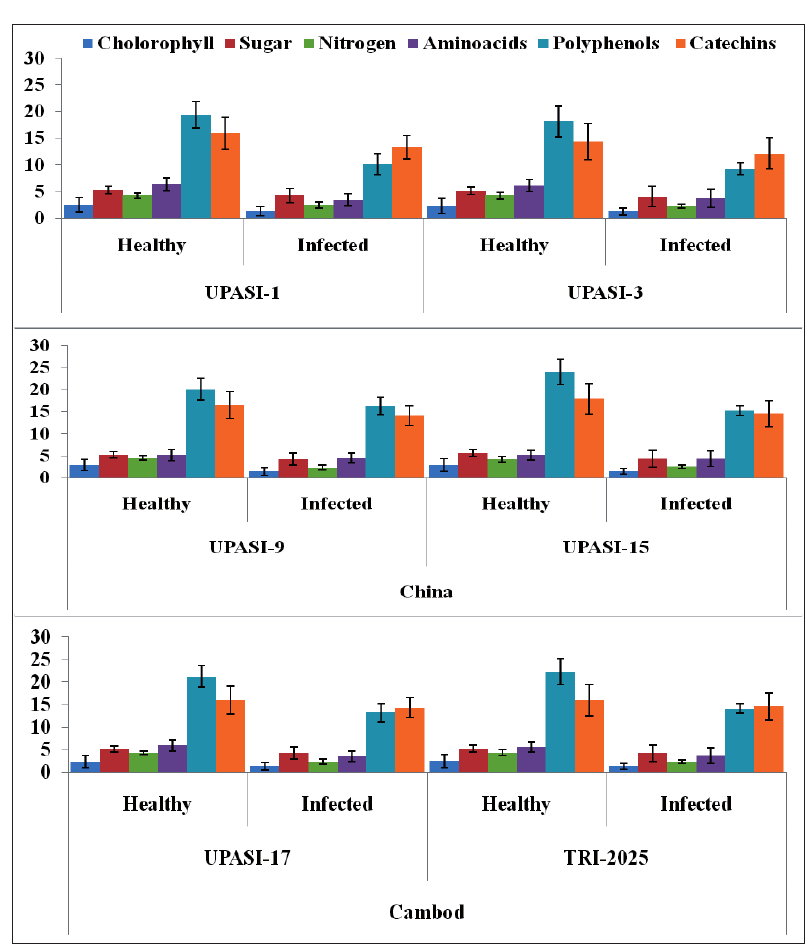
Fig. 4: Biochemical parameters of the harvestable tea shoot with respect to clones and blister blight